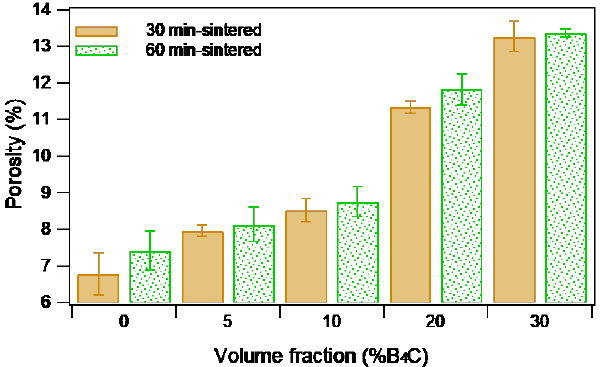
Figure 8. Change in the porosity (%P) after the sintering process as a function of the reinforcement ratio.